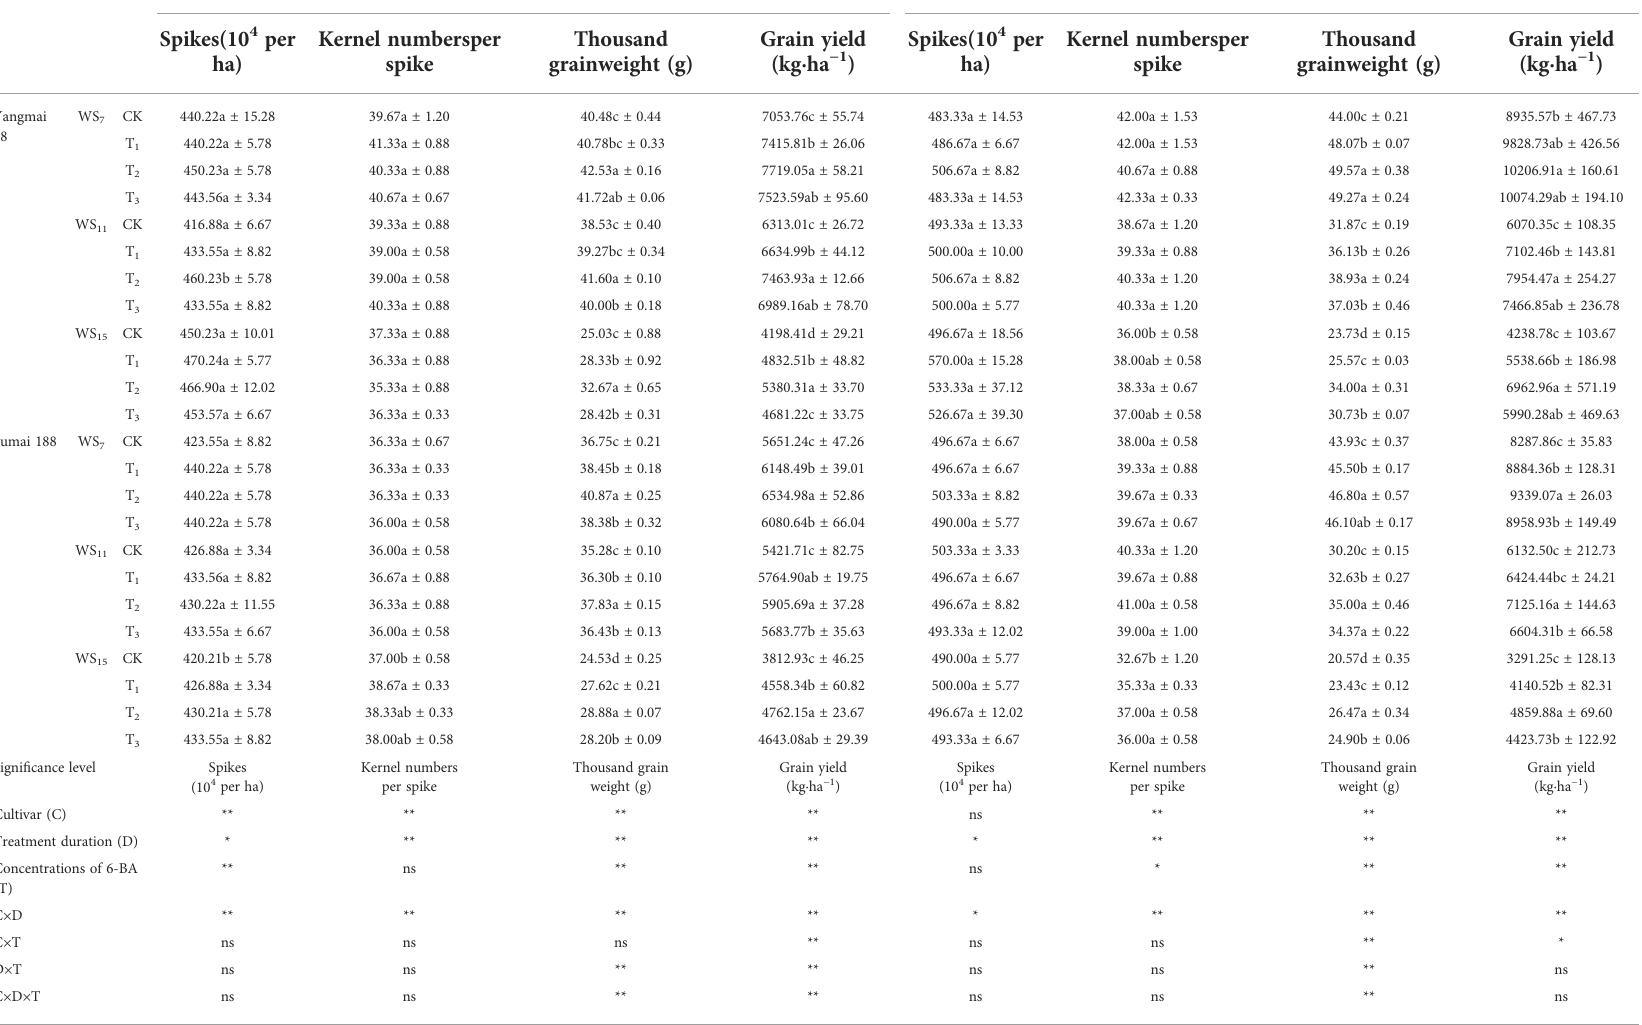
TABLE 5 The effect of exogenous 6-BA on wheat yield and its components under waterlogging and shading. Cultivar